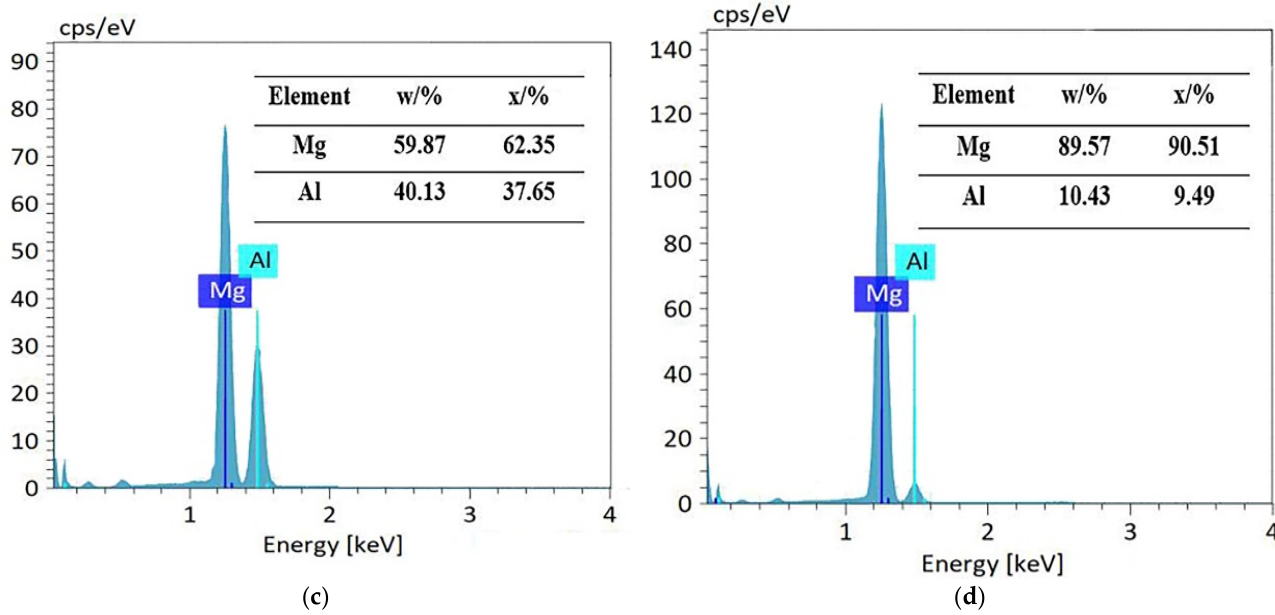
Figure 3. Elemental composition in different regions of the diffusion layer: ( a ) point A, ( b ) point B, ( c ) point C, and ( d ) point D.